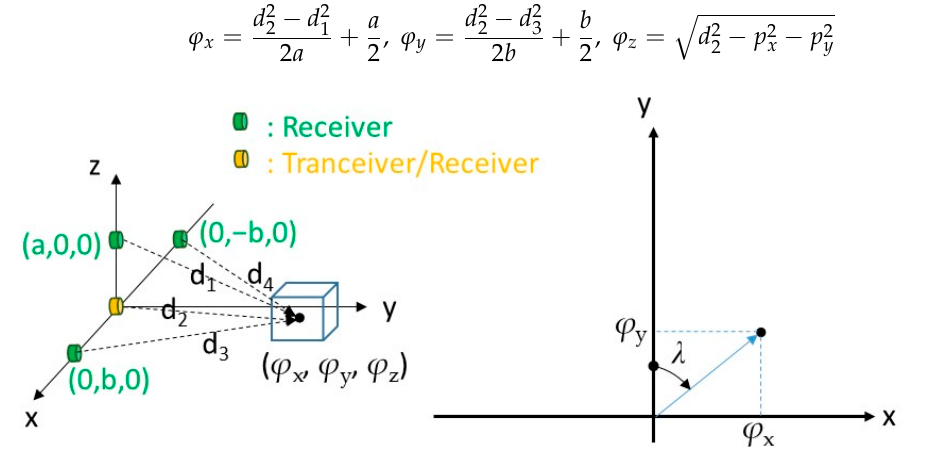
Figure 5. Configuration of obstacle detection using ultrasonic sensors. After this, the angular position λ of an obstacle in x - y plane can be defined as